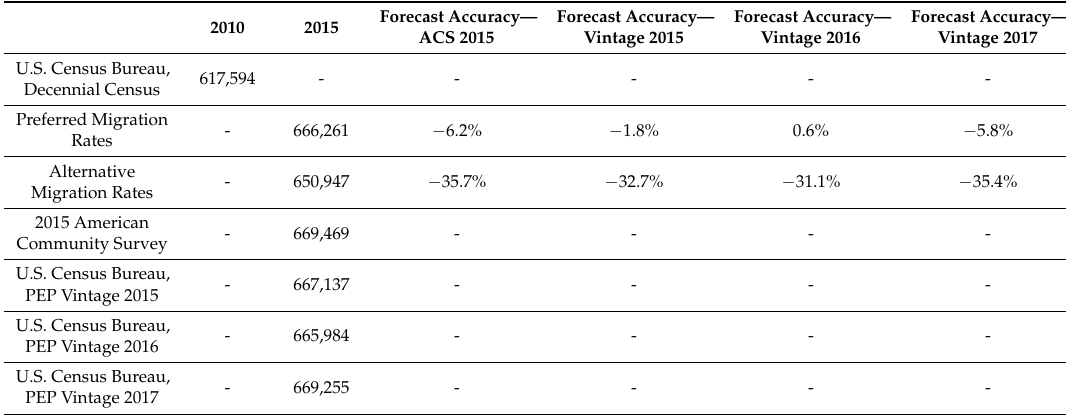
Table 1. Comparison of Residual Population Change by Program for Boston